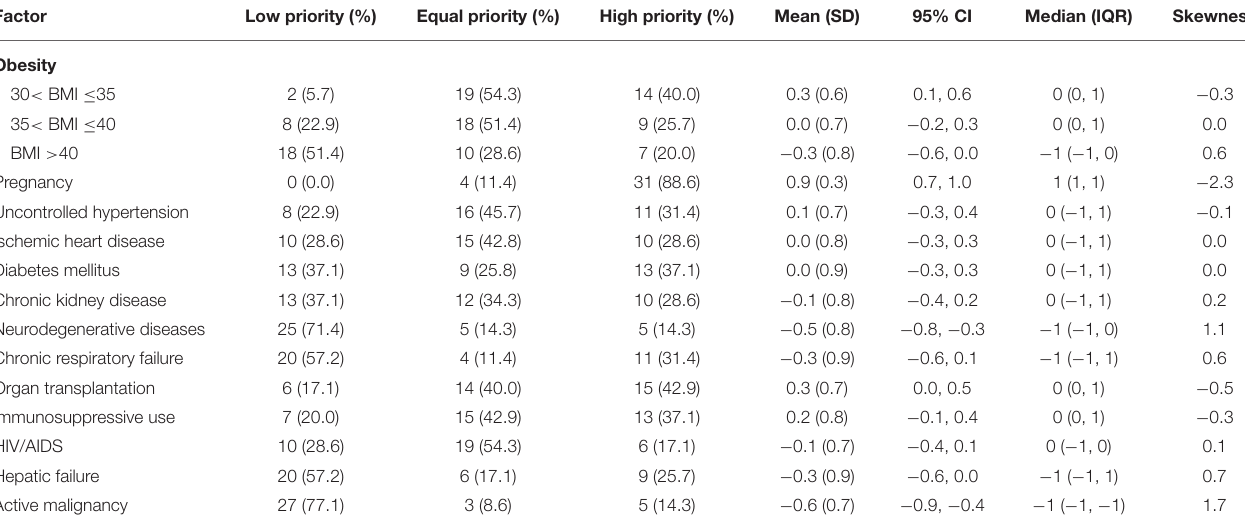
TABLE 3 | Responses on prioritising ventilator allocation regarding the underlying health condition of